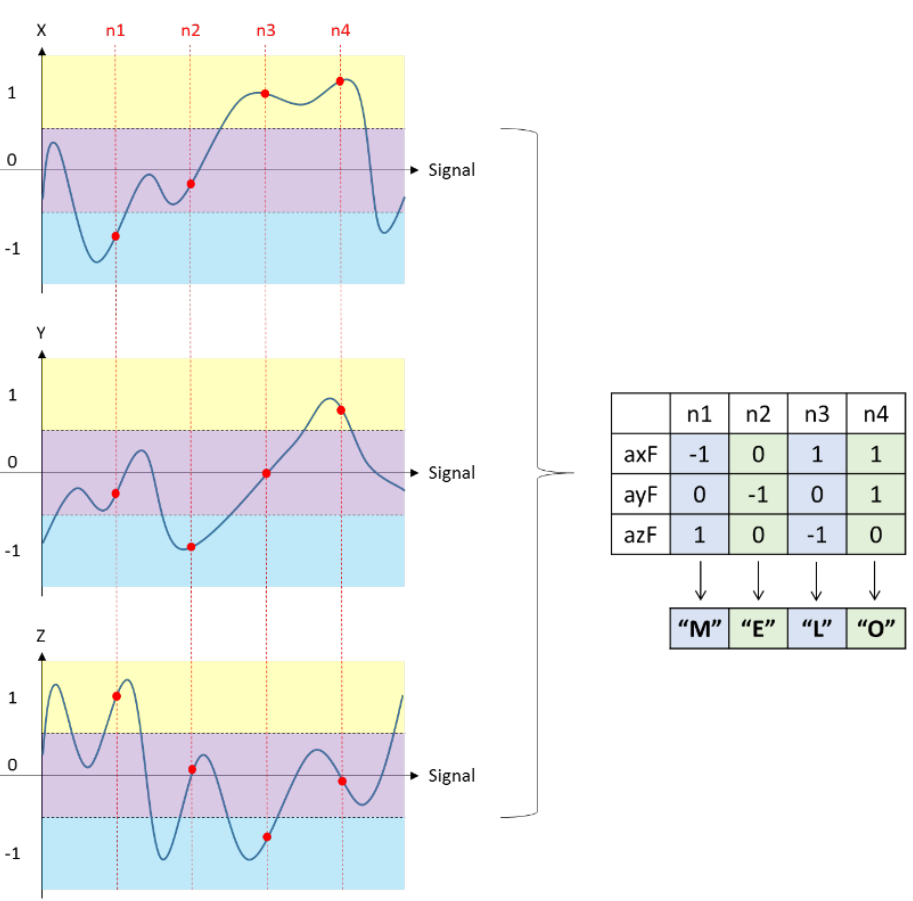
Figure 9. Action sequence conversion process.